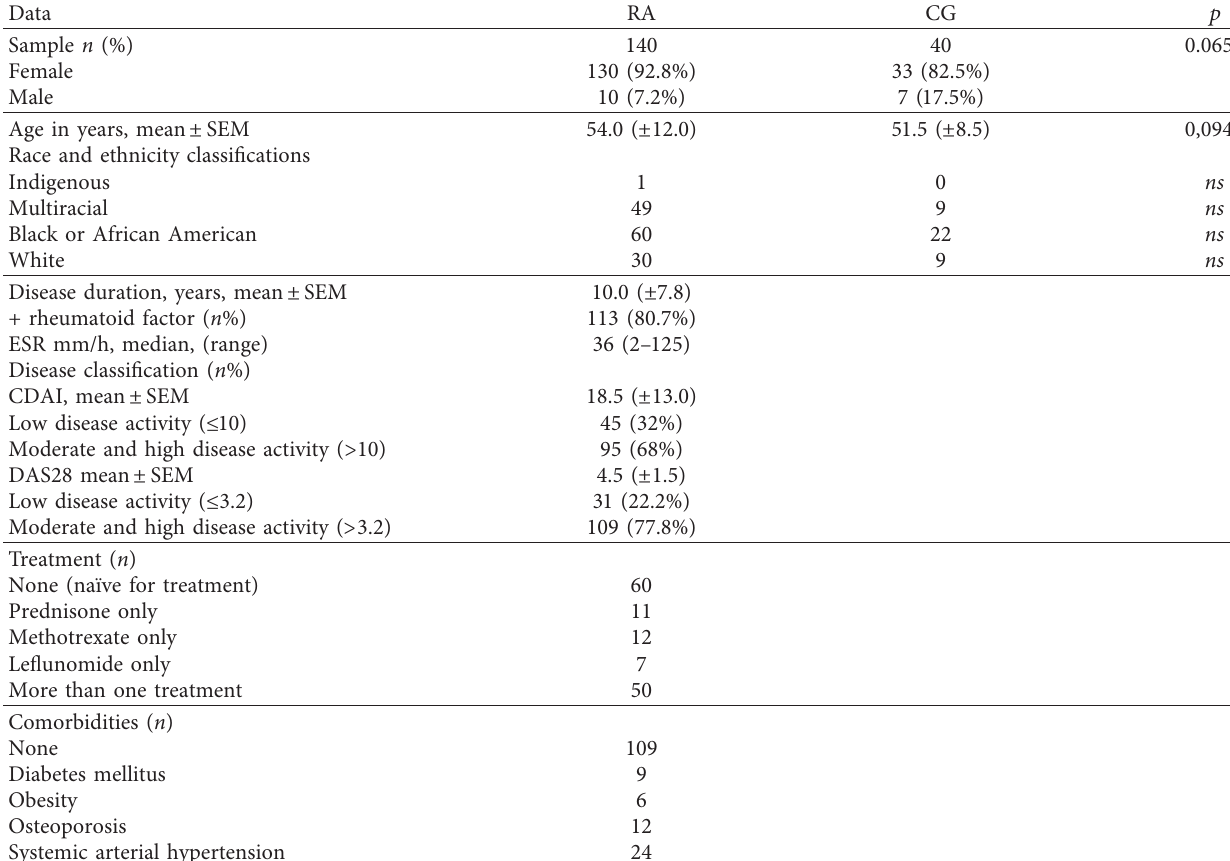
Table 1: Clinical and laboratory data for the RA and CG